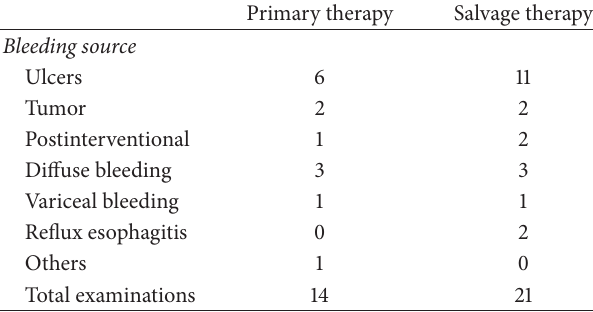
Table 2: Bleeding sources as noted during emergency endoscopy, divided according to the kind of Hemospray application (primary treatment versus salvage